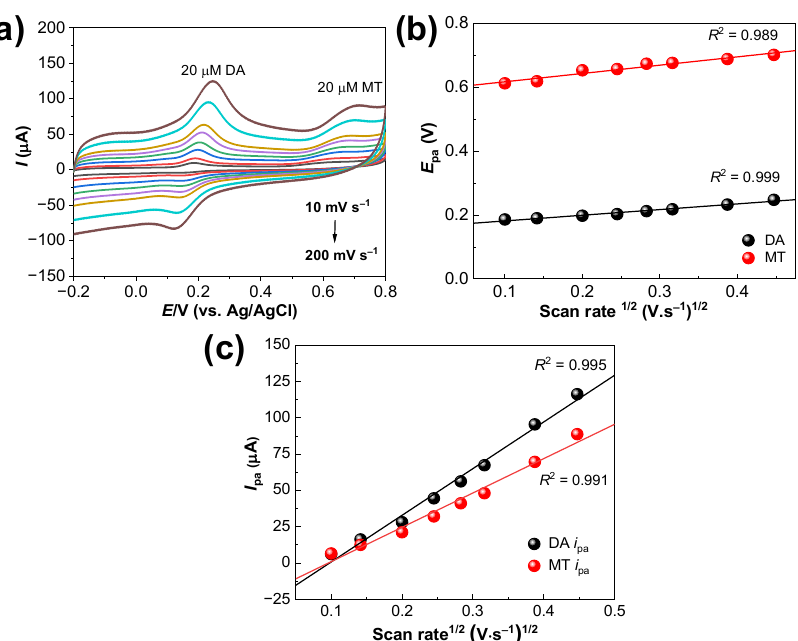
Figure 7. ( a ) CV results of the modified sensors in 20 μM of DA and MT with increasing scan rates (10–200 mV. s −1 ) and the corresponding plots of ( b ) E pa values and ( c ) I pa values.